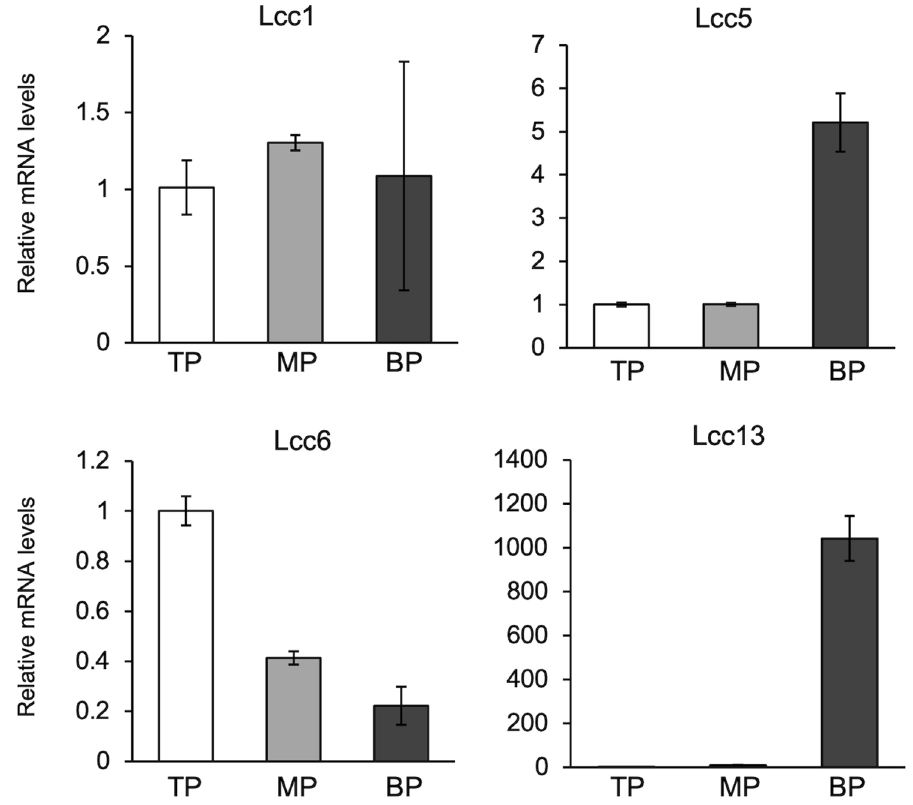
Fig. 5 Analysis of the transcription level of Lcc1, Lcc5, Lcc6, Lcc13 encoding genes using real-time PCR. TP, top part; MP, middle part; BP, bottom part. Quantities of mRNAs were relative to the level in TP. All data points are means ± SD (n =